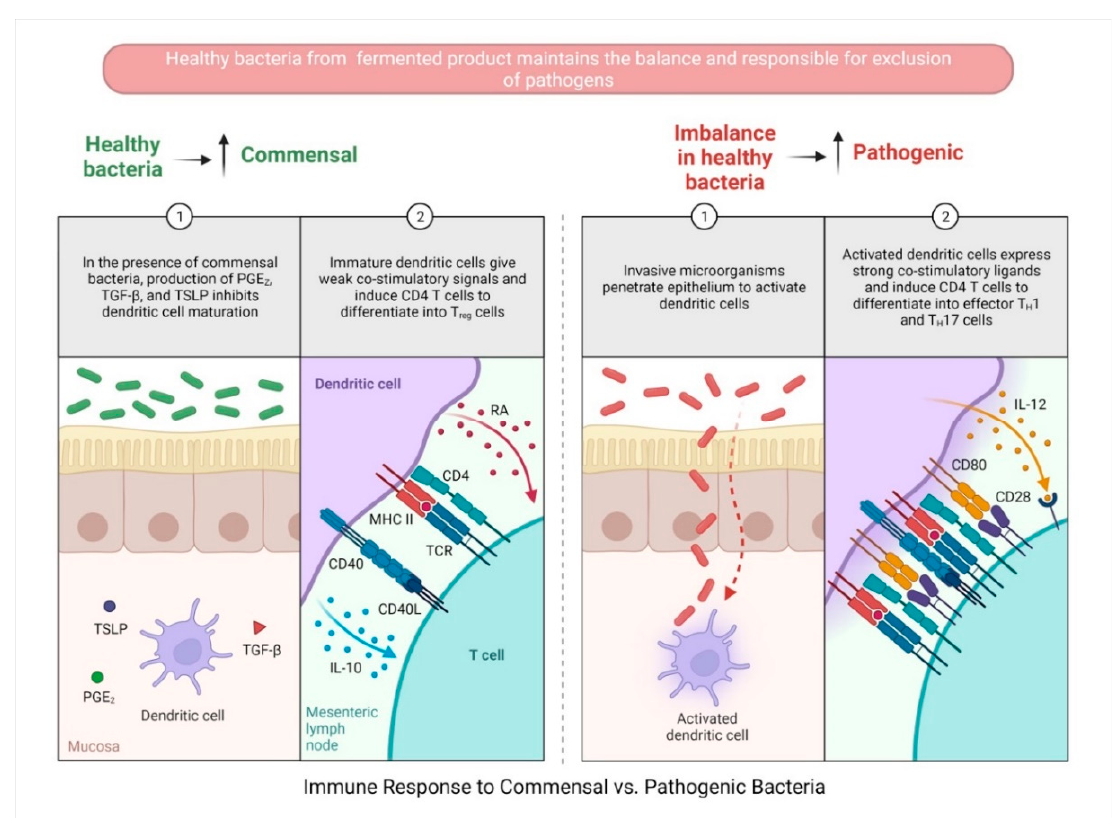
Figure 4. Healthy probiotic bacteria derived from fermented foods are responsible for keeping infections at bay and maintaining the immune system’s equilibrium.